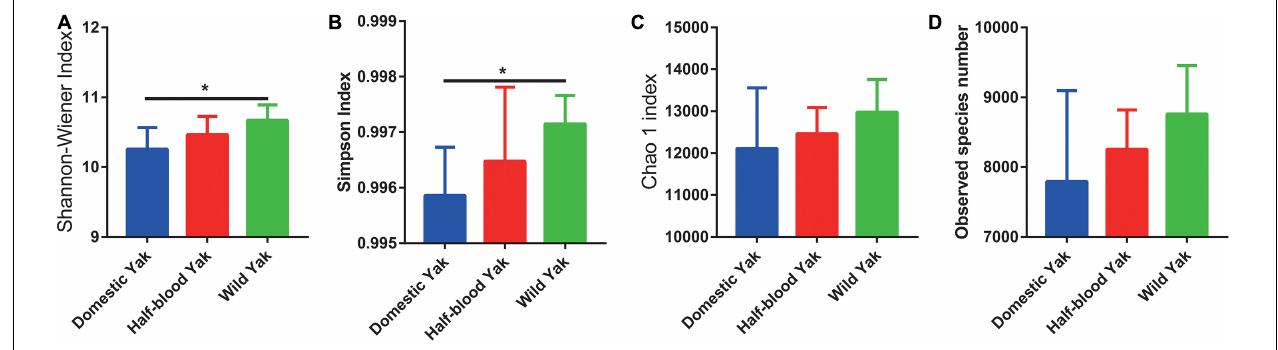
FIGURE 1 | The alpha diversity of gut microbial communities in three types of yaks, asterisks indicate significance level between groups ( p > 0.05, no significance; p < 0.05, *; p < 0.01, **; p < 0.001, ***). (A) The Chao 1 index (B) and observed species number. (C) The Shannon-Wiener, (D) and Simpson indices.